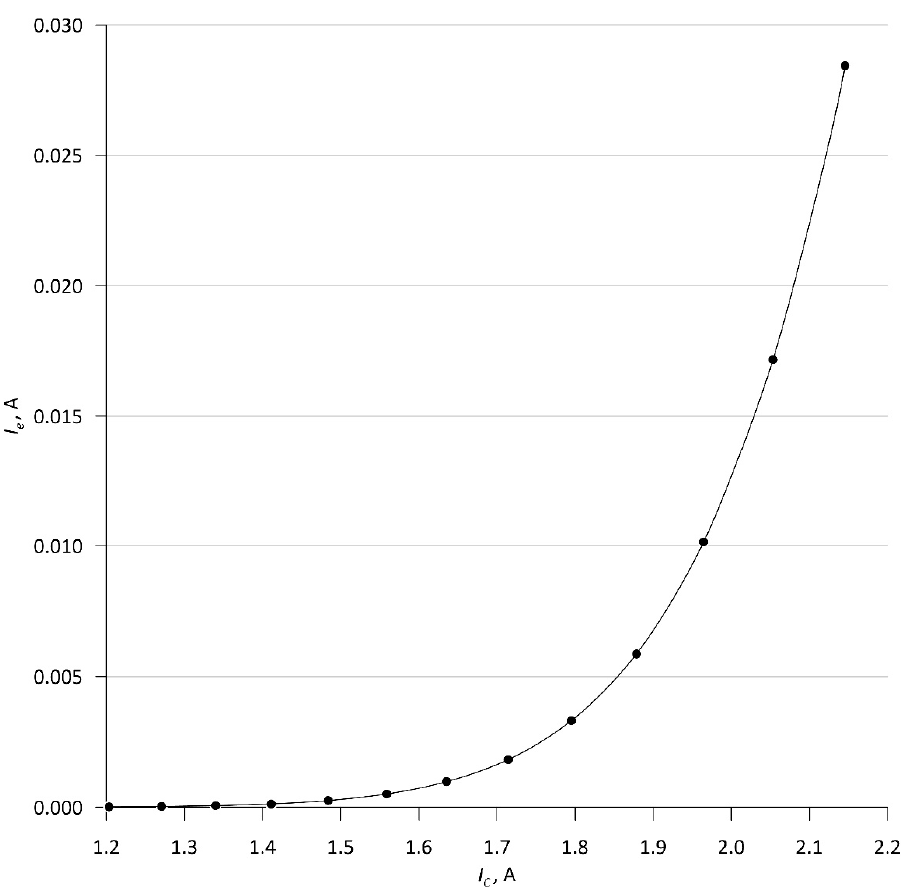
Figure A3. Model dependence of the emission current I e as a function of the cathode heating current I c , for a tungsten cathode with dimensions d = 0.00012 m and l = 0.045 m. The obtained dependence combines the electrical quantities of the input I c and the output I e of the thermionic electron source and is helpful in the simulation studies of the method of converting the emission current to voltage in the cathode power supply circuit.